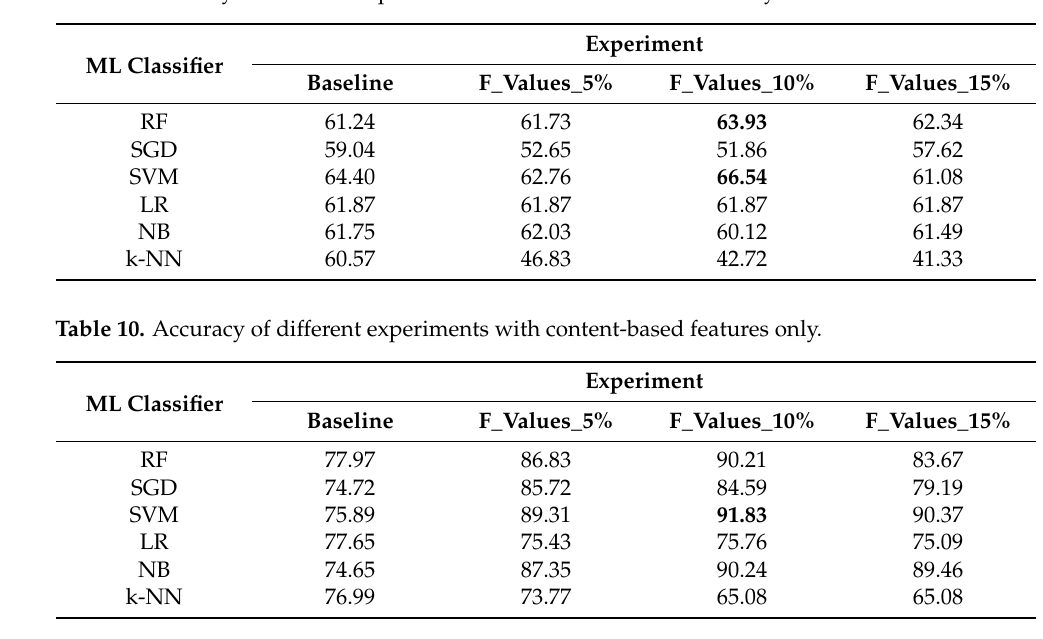
Table 9. Accuracy of different experiments with user-based features only.